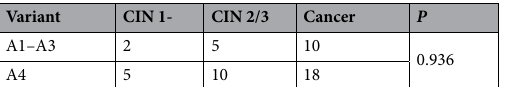
Table 2. Association between HPV16 variants and cervical cancer.